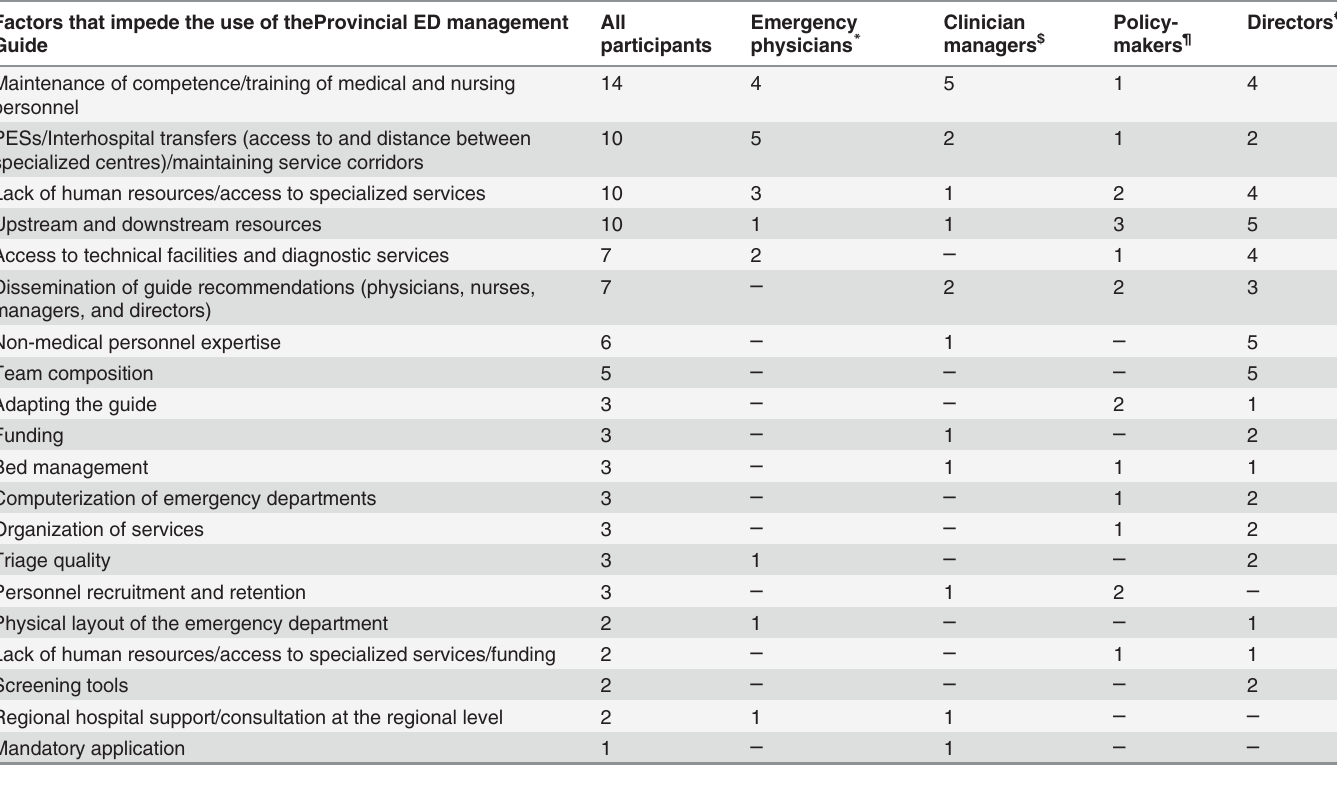
Table 4. Frequency of citing for factors that impede the use of the provincial ED management Guide, by entire sample and by job category. Factors that impede the use of theProvincial ED management